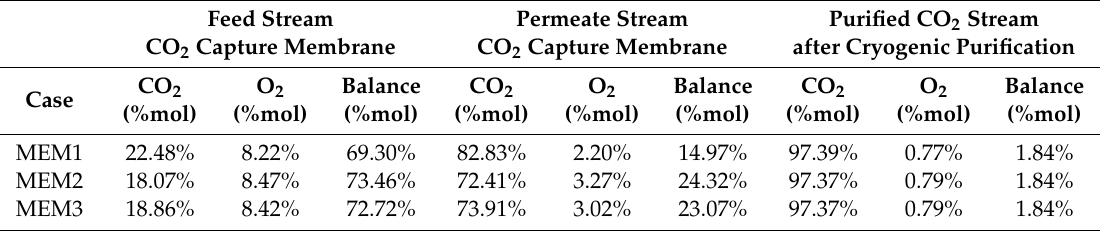
Table 10. Purities of relevant streams across the CO 2 capture membrane and of the dense-phase CO 2 purified by the cryogenic separation unit.